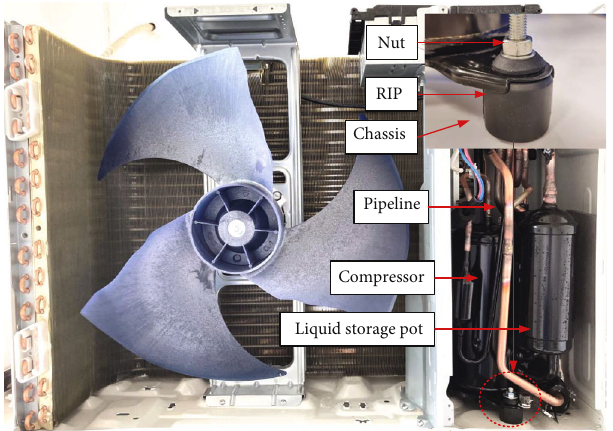
Figure 1: Air conditioner outdoor unit.